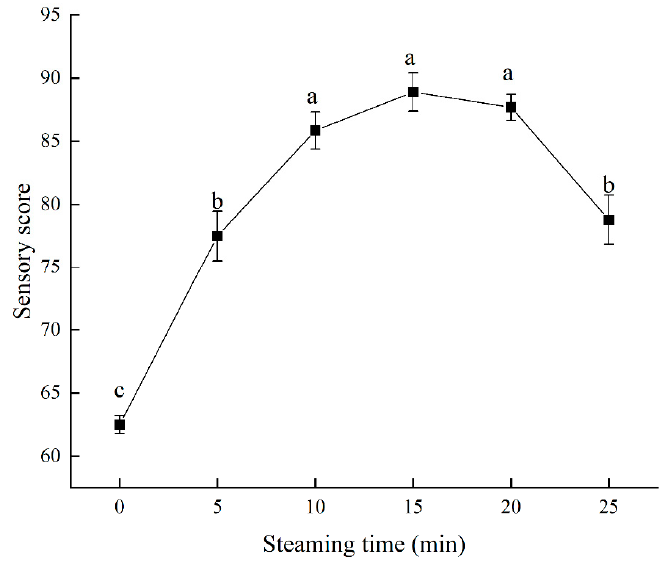
Figure 3. Sensory evolution of swimming crab meat during steaming. Different letters are significantly different at p <